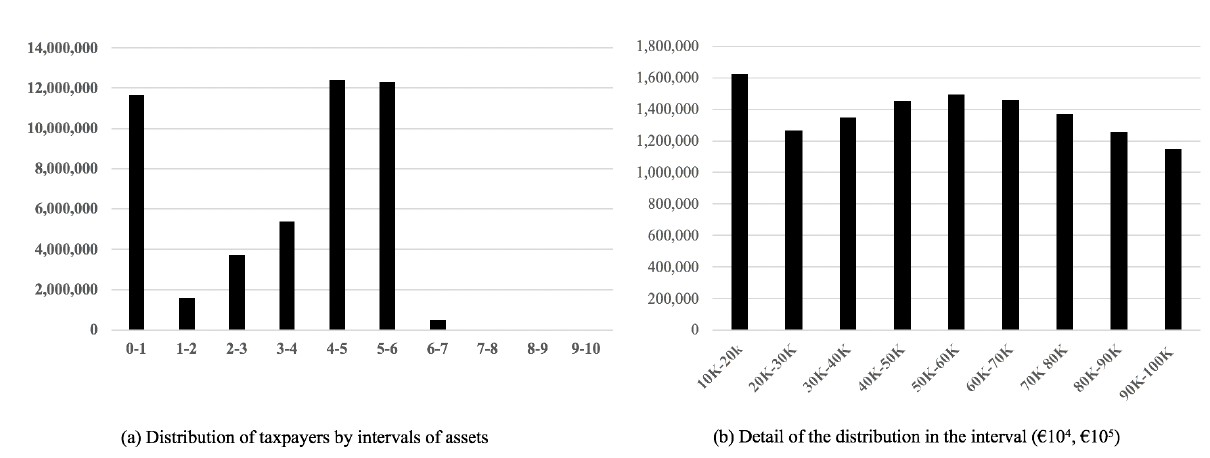
Figure 3. Assets by